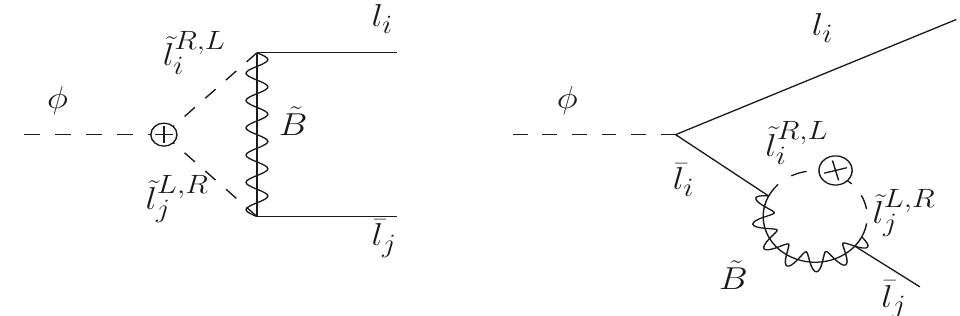
Figure 2. Photon, Z-boson and neutral Higgs boson mediated penguin diagrams and box-type of diagram contributing to l j 3 l i decay. !